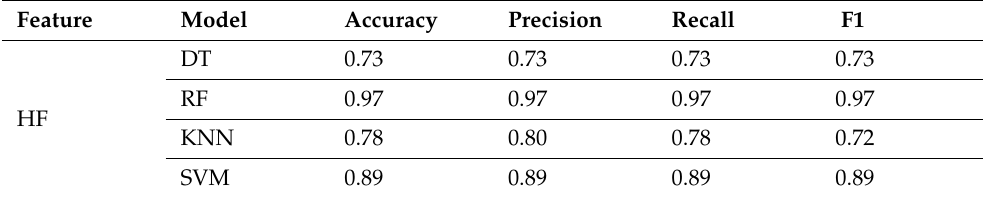
Table 11. Results of models using the hybrid features from an oversampled dataset.